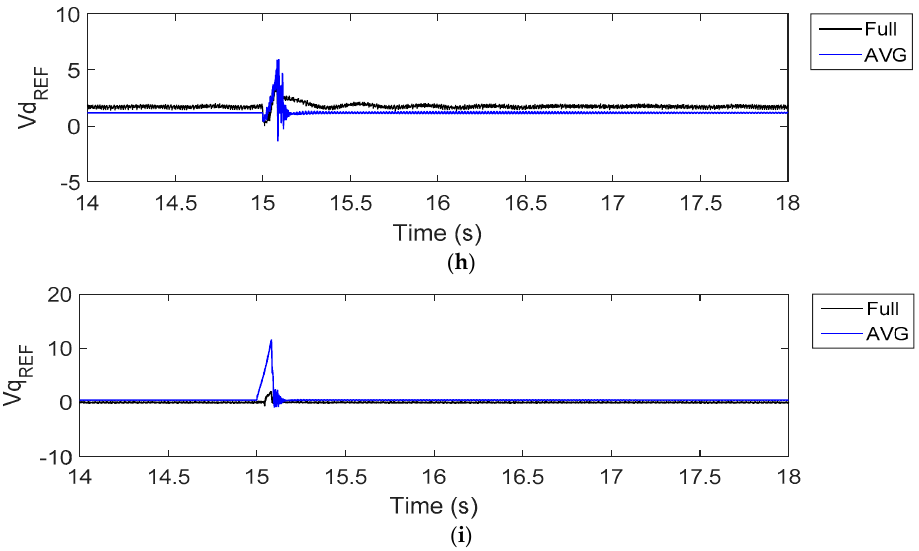
Figure 12. Outputs with 3-phase to ground fault of 0.1 Ω at HV side of substation transformer with unbalanced loads connected to DFIG Bus: ( a ) active power, ( b ) reactive power, ( c )load bus voltage, ( d ) DC voltage, ( e ) DFIG speed, ( f ) I d at the rotor side, ( g ) I q at the rotor side, ( h ) V d , ( i ) V q .